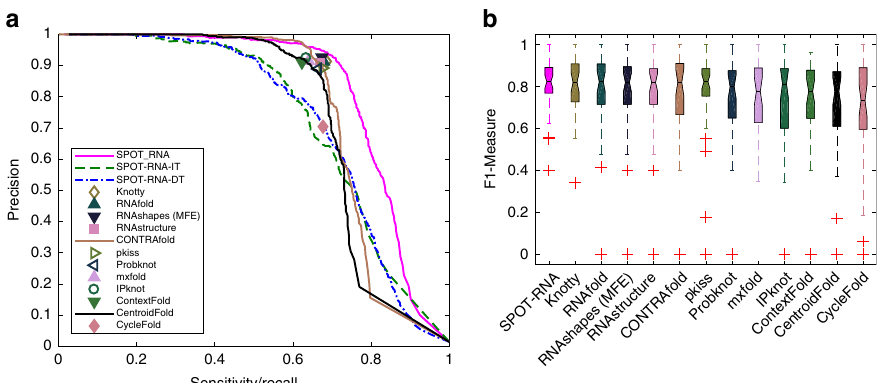
Fig. 3 Performance comparison of SPOT-RNA with 12 other predictors by using PR curve and boxplot on the test set TS2. a Precision-recall curves on the independent test set TS2 by various methods as in Fig. 2a labeled. b Distribution of F1 score for individual RNAs on the independent test set TS2 given by various methods as in Fig. 2b